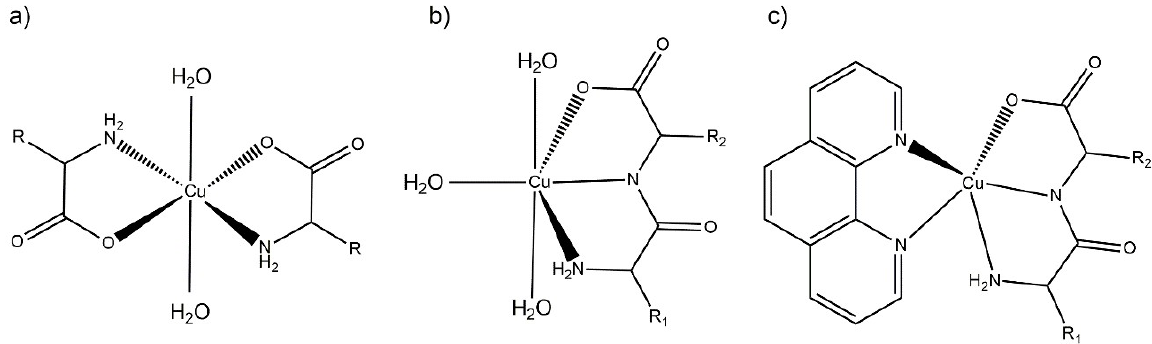
Figure 3. Scheme representation of the proposed aqueous solution coordination environment for: ( a ) Cu–AA, ( b ) Cu–dipeptide and ( c ) Cu–dipeptide–phen complexes. R 1 and R 2 represent different substituents.